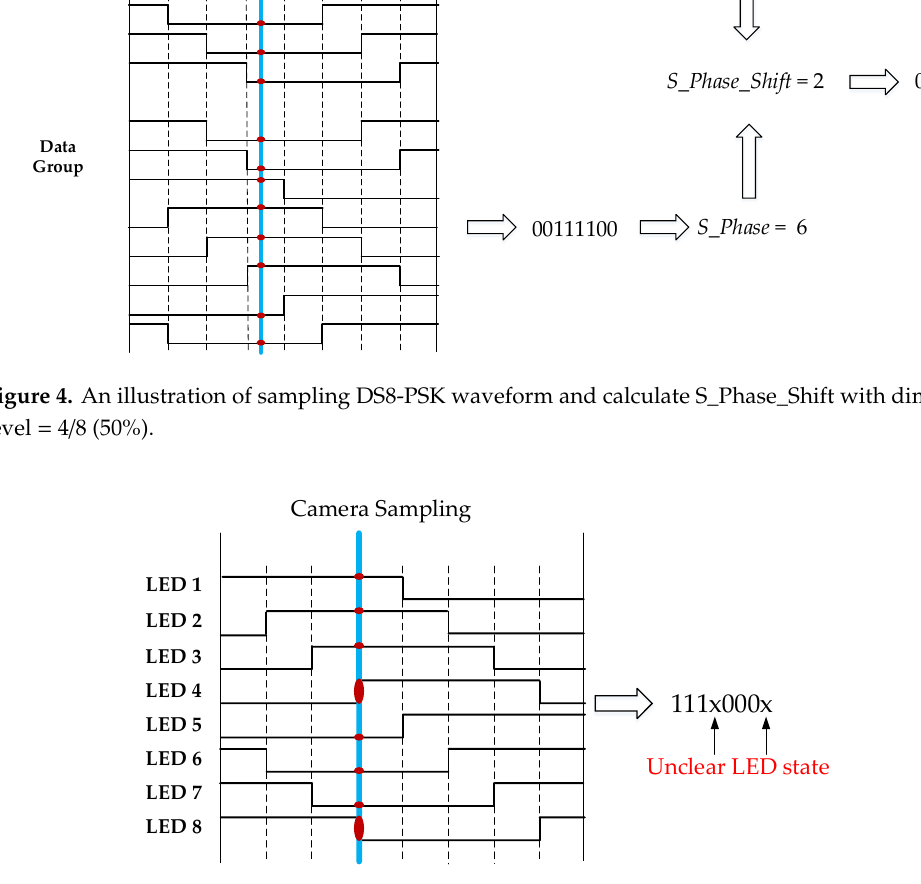
Figure 5. An illustration of bad-sampling issues on the receiver (Rx) camera and the set of LED group states including unclear LED states (dimming level = 4/8). Table 3. S_Phase value definition for the captured set of unclear LED group states under dimming condition (Adapted from [30]).